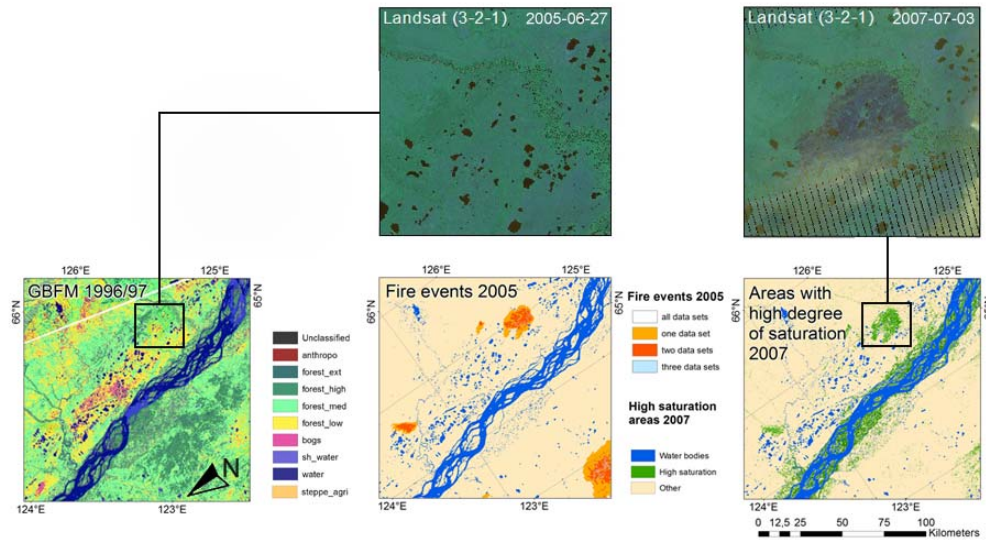
Figure 12. Distribution of land cover types from the GBFM map [33] of 1996/1997 including bogs (purple) compared with the saturated area map of 2007. In 2005 large forest fires occurred as documented in the DUE Permafrost burnt area map [38]. Universal Polar Stereographic projection, extent: S1 in Figure